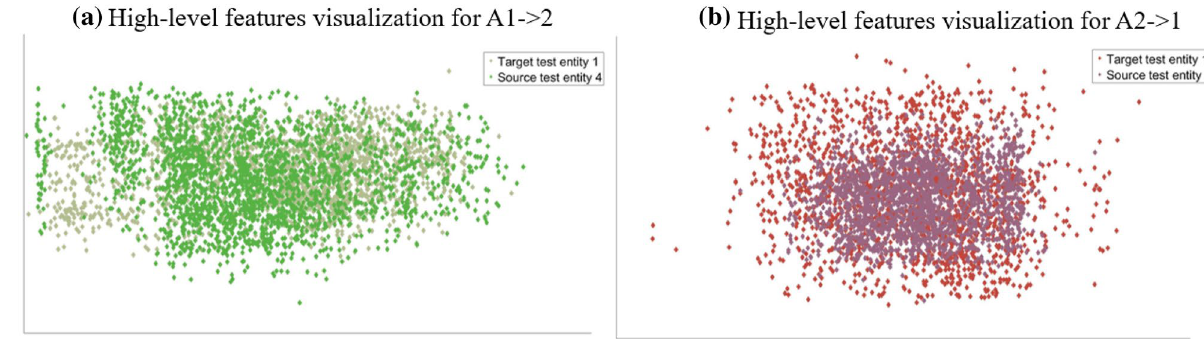
Figure 7. The feature visualization for cross-condition.